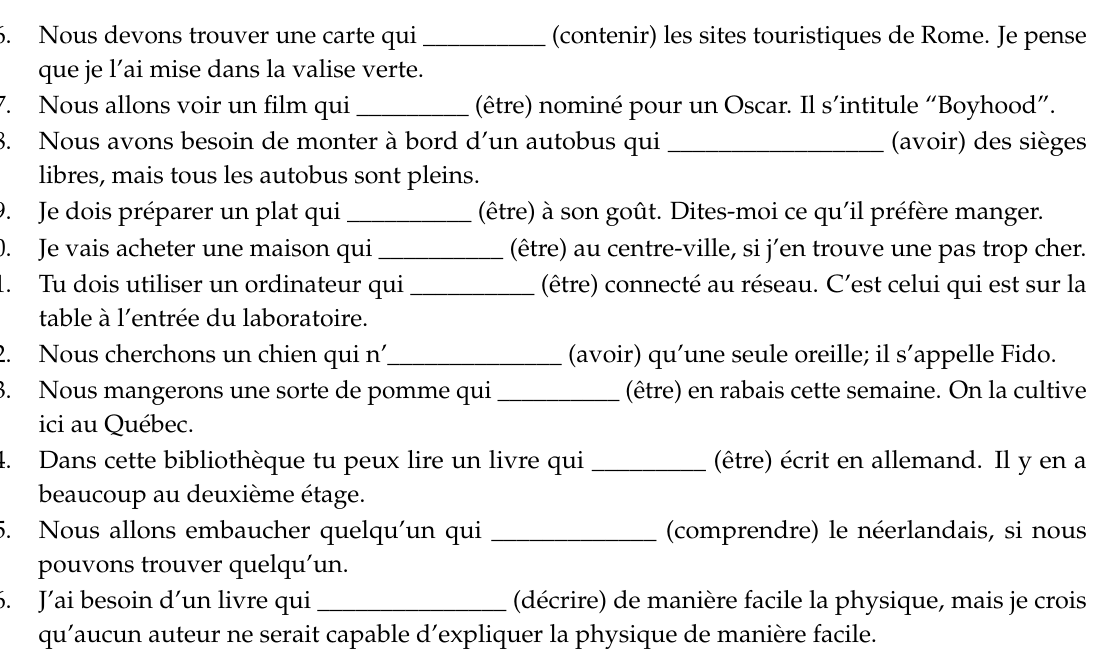
table à l’entr é e du